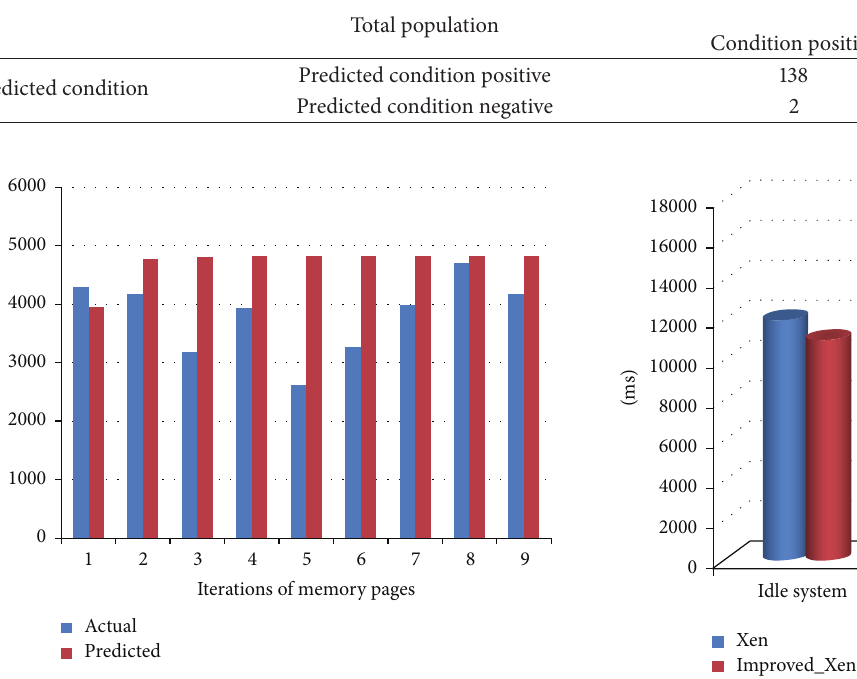
Figure 5: Total migration time for normal workloads.